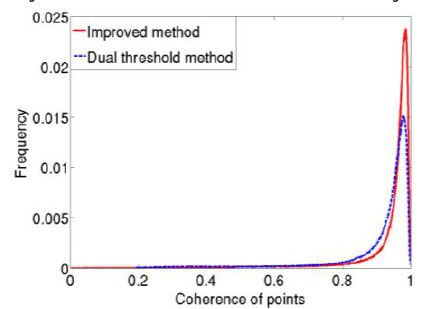
Figure 9. Coherence histogram of PS points